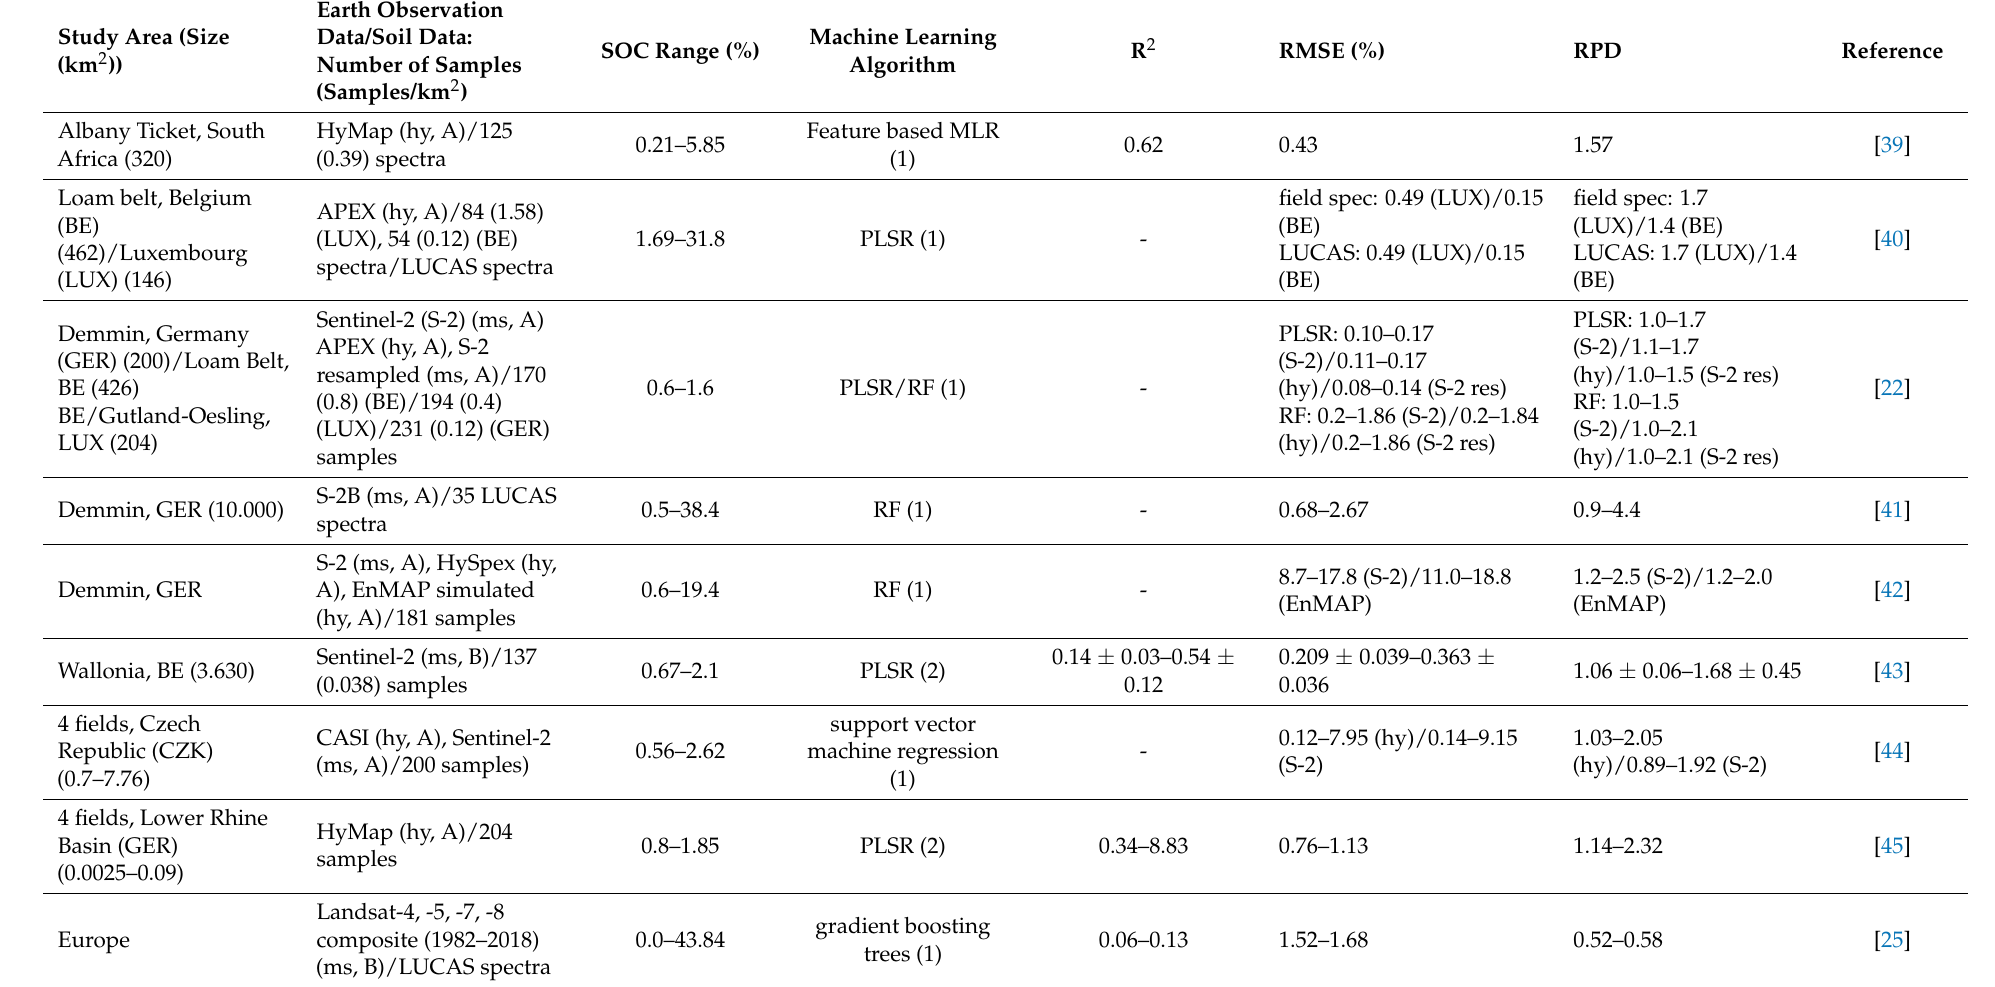
Table 1. Overview on soil organic carbon (SOC) modeling studies across different regions in